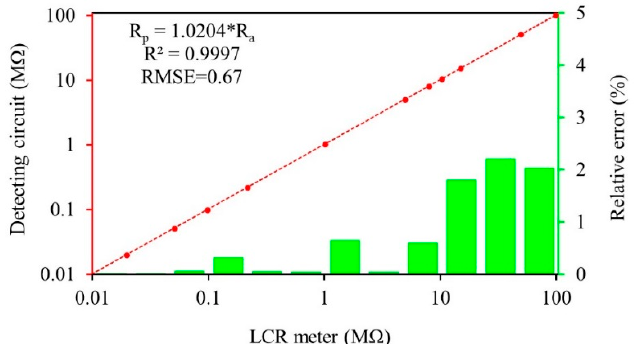
Figure 4. The relationship between resistance values measured by the detecting circuit and the impedance meter.